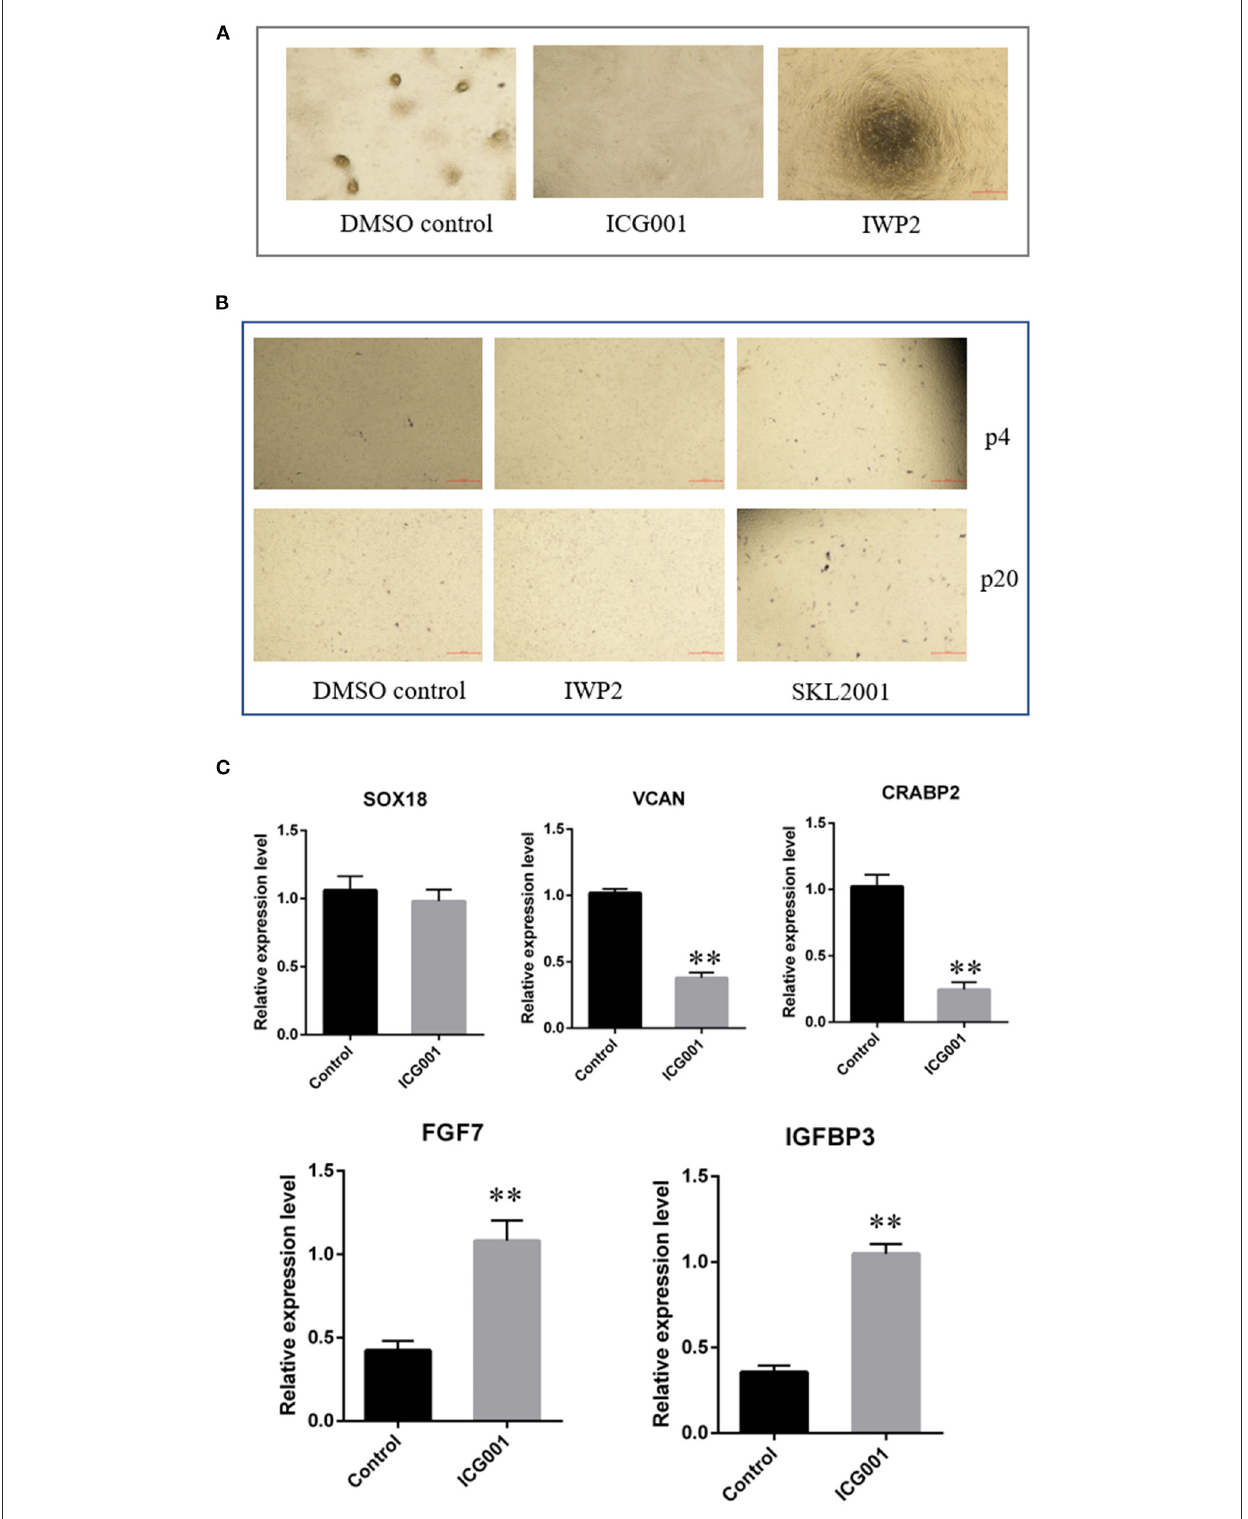
FIGURE5 The effect of Wnt signaling on DPCs intrinsic properties. (A) The effect of Wnt signaling on cell aggregation of DPCs. (B) The effect of Wnt signaling on alkaline phosphatase activity of DPCs. (C) qRT-PCR of marker genes of ovine DPCs treated with Wnt/ β -catenin antagonist ICG001. The data was expressed as the mean ± SE ( n = 3). ** P <